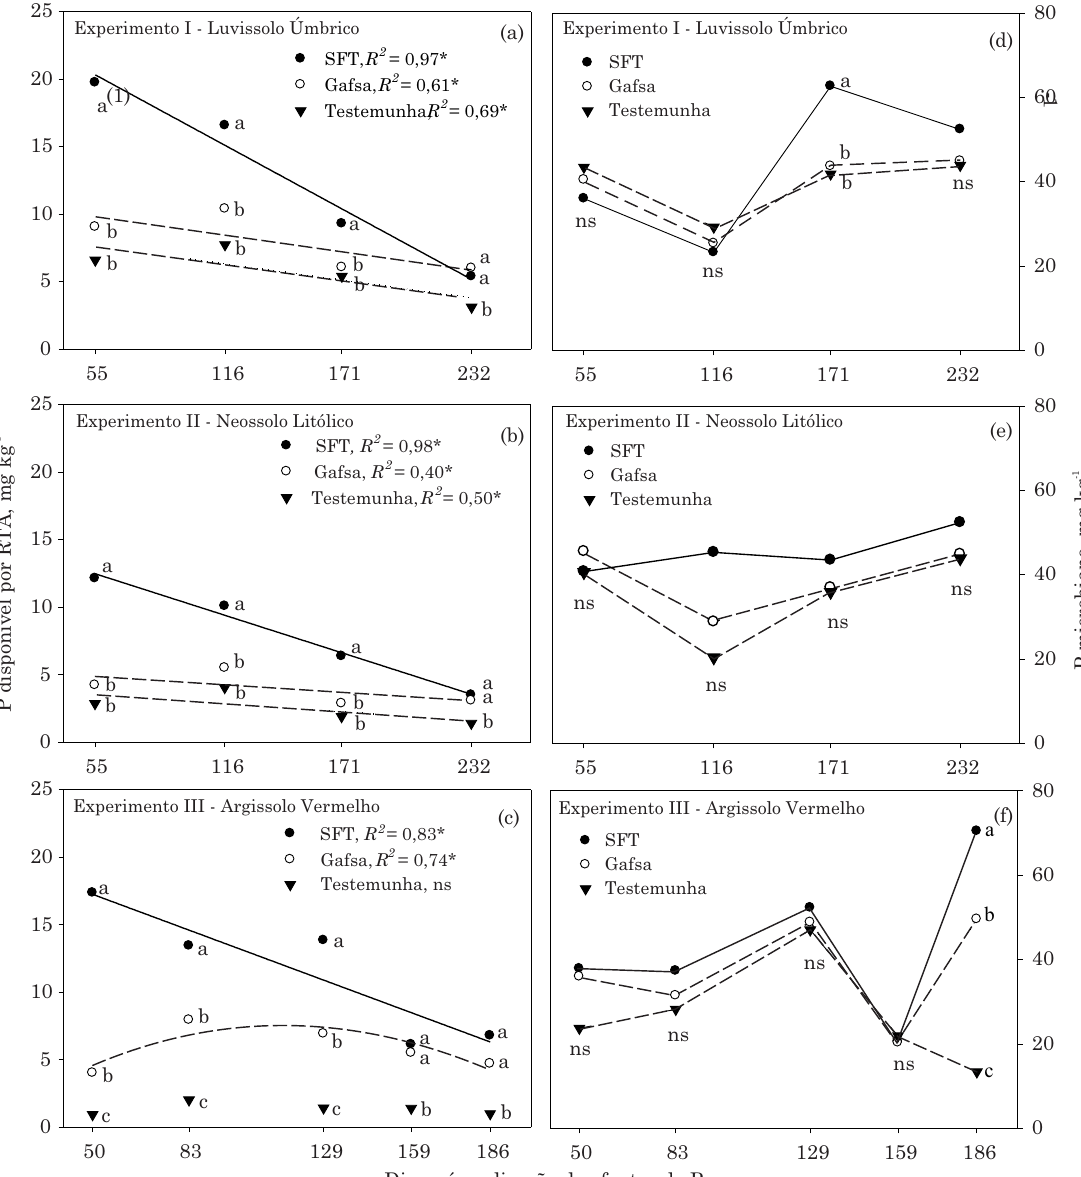
Figura 2. Variação do teor de P extraído por RTA (a, b, c) e teor de P armazenado na BMS (d, e, f), após a aplicação de fontes de fosfato em solos sob pastagem natural. Diferença significativa a p<0,05 entre épocas de avaliação. Médias seguidas pela mesma letra em cada época de avaliação, comparando as fontes de fosfato, não diferem significativamente entre si em nível de p<0,05 pelo teste de Tukey; e ns: não